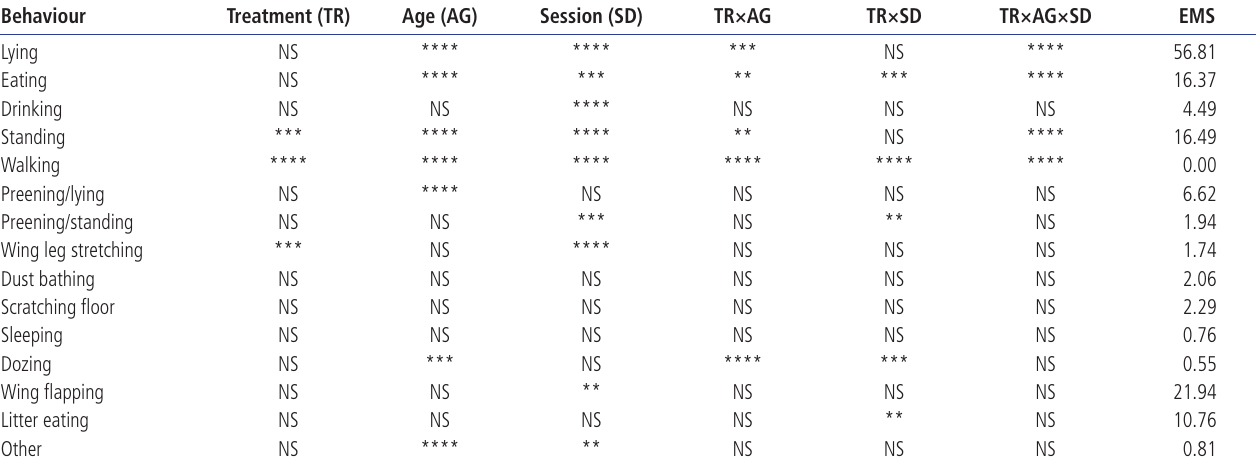
Table 3. Level of significance of the effect of different intensities of RD light treatment (TR), age (AG), and daysession (SD) and their interactions